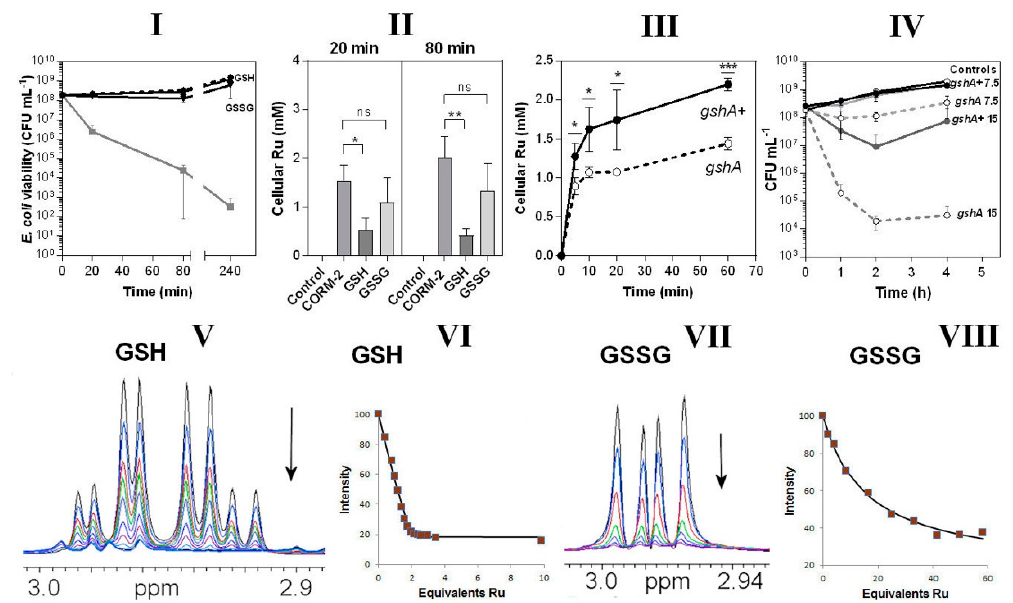
Figure 6. Glutathione is an important intracellular and extracellular target of CORM-2 ( I – IV ) and CORM-2 has a much higher affinity for reduced glutathione (GSH) than oxidised glutathione (GSSG) as investigated by 1 H NMR (V–VIII). In I , the effects are shown of extracellular reduced glutathione (GSH) or oxidised glutathione (GSSG). The grey line shows cell viability with CORM-2 alone. GSH fully restored viability to that of the no-CORM control (dashed line). II shows CORM-induced intracellular Ru accumulation in the absence or presence of GSH or GSSG (* p ≤ 0.05, ** p ≤ 0.01, assessed via unpaired t-test). CORM-2 stocks were incubated with a 2-fold excess of the compound prior to addition of 30 μ M CORM-2. ( III ) Uptake of CORM-2-derived Ru is significantly reduced in a glutathione-deficient mutant ( gshA , open symbols, dashed line) compared to the GshA + wild-type parent strain ( gshA + , solid line) (* p ≤ 0.05, *** p ≤ 0.001, assessed via unpaired t -test). ( IV ) Culture viability (CFU mL − 1 ) of the glutathione-deficient strain compared to the parent strain following addition of 7.5 or 15 μ M CORM-2. Data in I – IV represent 3 biological repeats ± SD. ( V ) NMR spectra of the Cys H β resonances of GSH (1 mM) on titration with 0–5 mM CORM-2 and ( VI ) corresponding binding curve. ( VII ) NMR spectra of the Cys H β resonances of GSSG (0.5 mM) on titration with 0–14.5 mM CORM-2 and ( VIII ) corresponding binding curve. In each titration the arrow shows the direction of increasing [CORM-2]. The estimated K d of CORM-2 to GSH was determined to be: 2 ± 1 μ M for GSH (VI) and 25 ± 5 mM for GSSG ( VIII ). Titrations were performed in 30 mM KPi buffer pH 7.4 and pH was maintained by adjustment with KOH throughout the experiment.